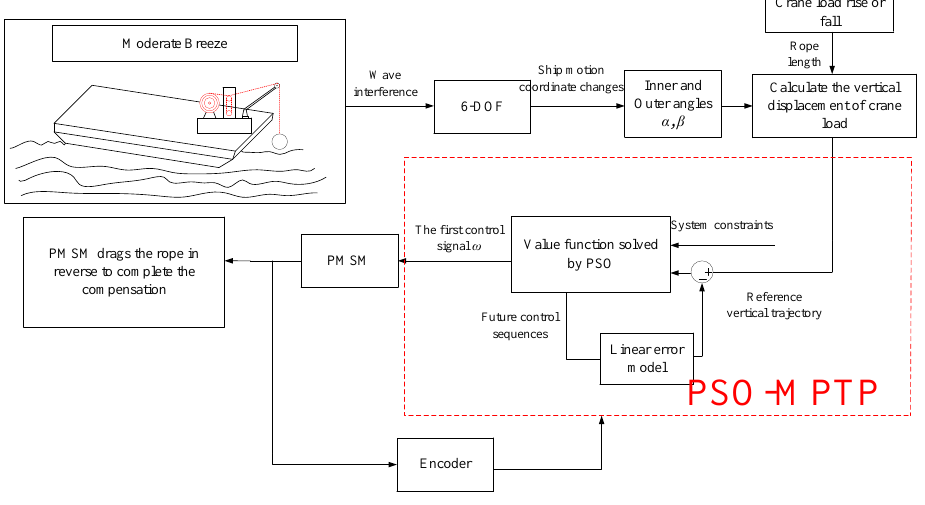
Figure 4. The overall flow chart of the system.